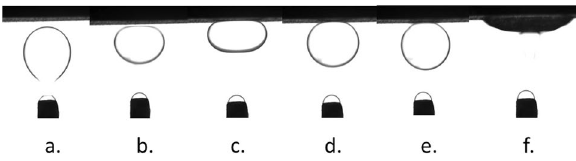
Fig. 1 Procedure of dispensing an oil drop on a steel surface in water: a – e bouncing of the drop due to a water film and posterior deposition with a contact angle signifying good wetting by the hydrocarbon phase ( f )